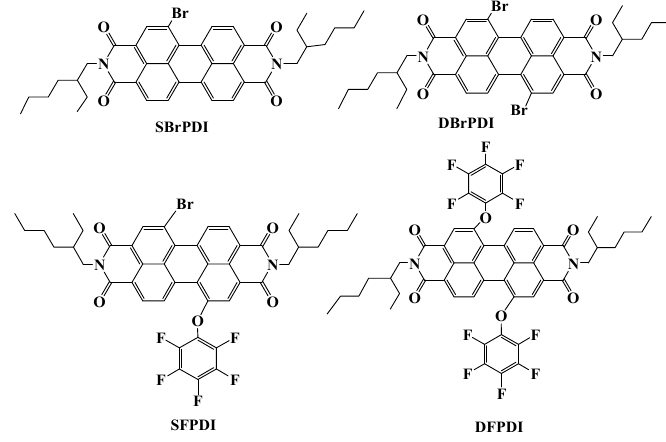
Figure 6. Molecular structures of the dyes SBrPDI, DBrPDI, and SFPDI, DFPDI.